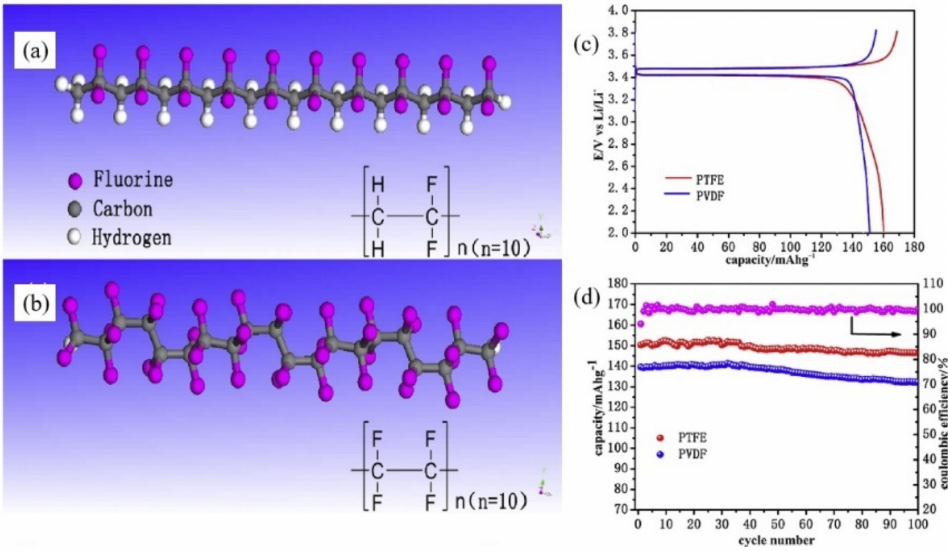
Figure 2. Chemical structures of ( a ) PVDF and ( b ) PTFE. ( c ) The first charge/discharge curves of PTFE and PVDF electrodes at 0.1C. ( d ) Cycle stability of cathodes prepared form PVDF and PTFE evaluated at 0.2C rate. Reprinted with permission from ref. [42]. Copyright 2015